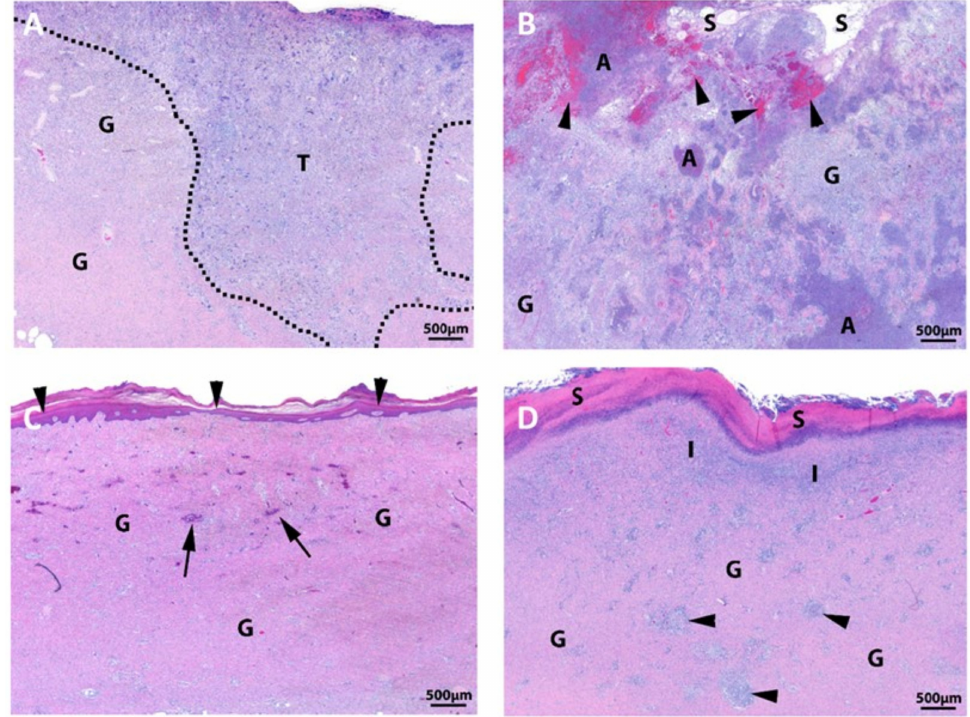
Figure 3. Histology images of full-thickness wounds stained with hematoxylin and eosin (H&E) at days 15 ( A , B ) and 30 ( C , D ) treated with the synthetic matrix ( A , C ) or the bilayer xenograft ( B , D ). Re- sults showed that the synthetic matrix had less inflammation and faster filling of the wound bed with granulation tissue compared to the xenograft matrix. G—granulation tissue; T—area of granulation tissue containing inflammation and wound matrix; A—area of abscessation; S in ( B )—seroma (edema) formation; S in ( D )—serocellular debris; I—inflammation within granulation tissue; arrowheads in ( B )—hemorrhage within wound bed; arrowheads in ( c )—epithelium; arrowheads in ( D )—small microgranulomas; arrows—blood